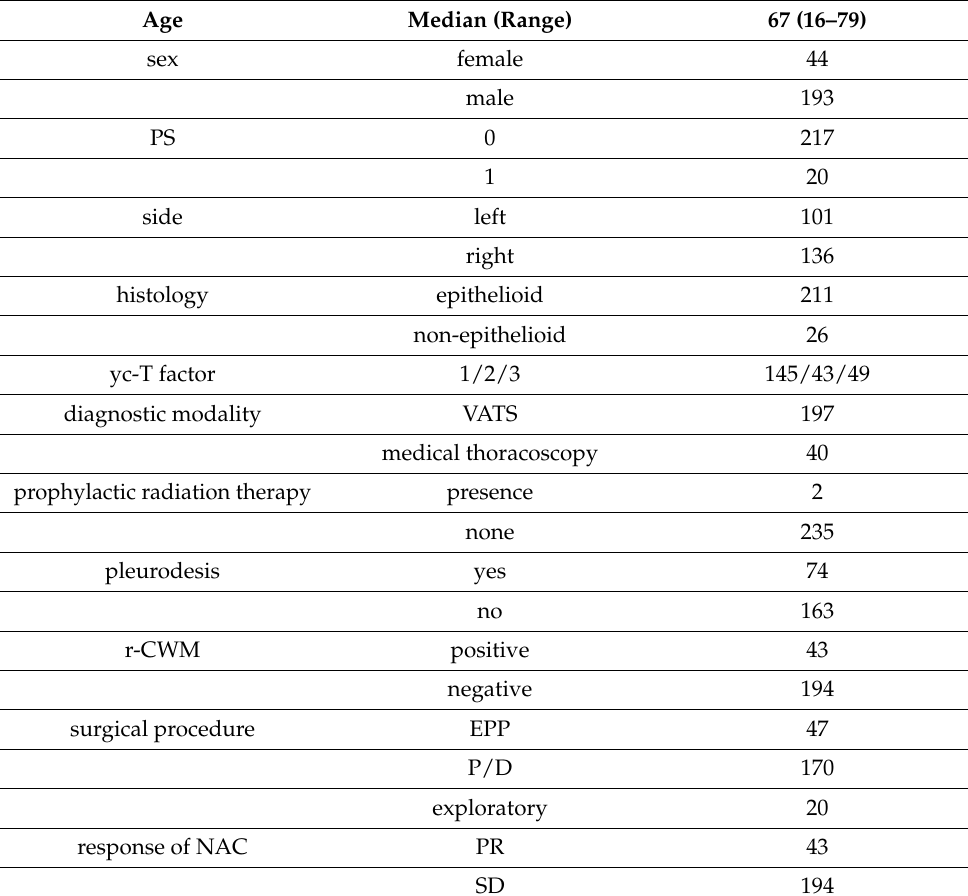
Table 1. Patients’